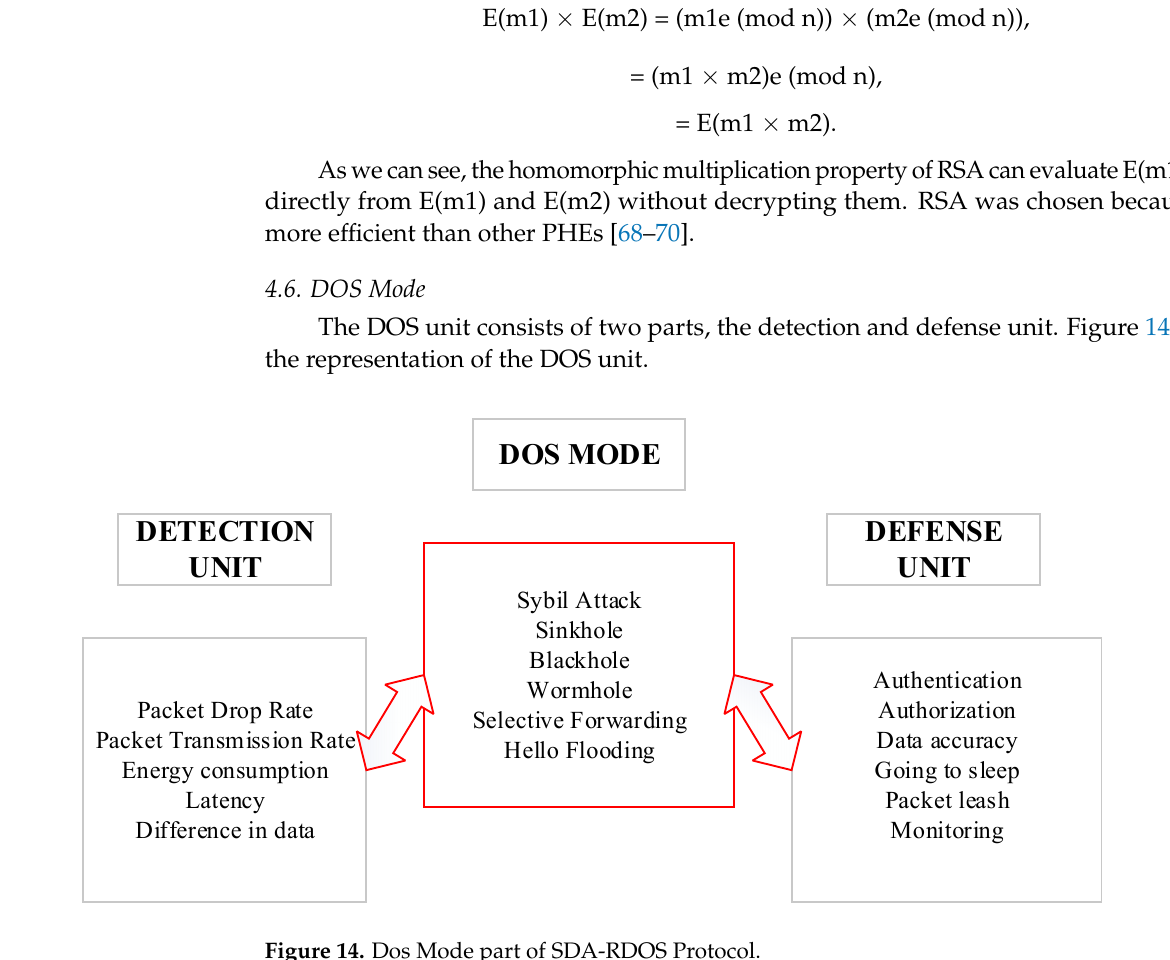
Figure 14. Dos Mode part of SDA ‐ RDOS Protocol.